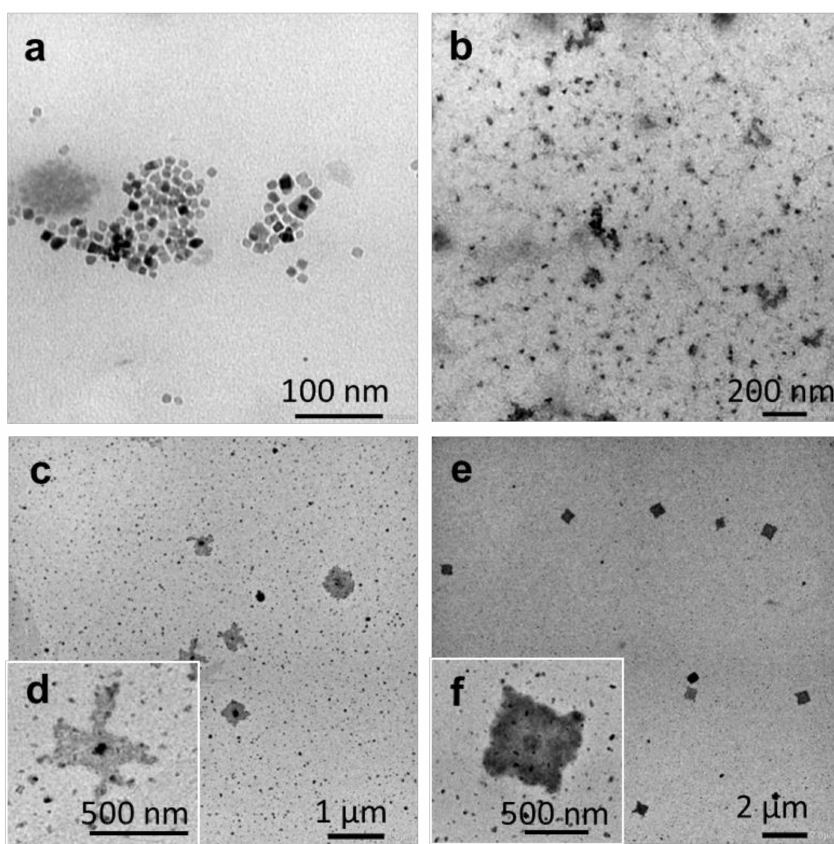
Figure 6. TEM images of self-assembled P(VDF- co -HFP)- b -PEG- b -P(VDF- co -HFP) triblock copolymer using nanoprecipitation in octanol from a 1 mg mL − 1 THF solution: ( a ) Final concentration 0.1 mg mL − 1 . The solution was heated to 180 ◦ C for 1 h and slowly cooled down to room temperature. Structures observed after: ( b ) 0 h, ( c , d ) 12 h, and ( e , f ) one